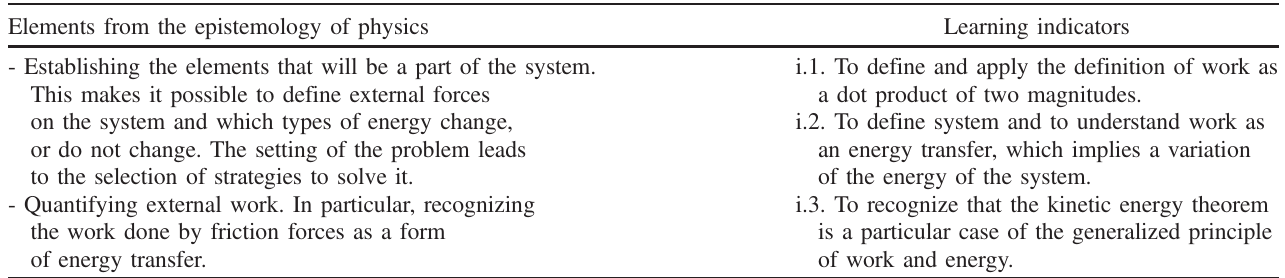
TABLE I. Learning indicators to define the work concept and the limitations of the kinetic energy theorem. Elements from the epistemology of physics Learning indicators